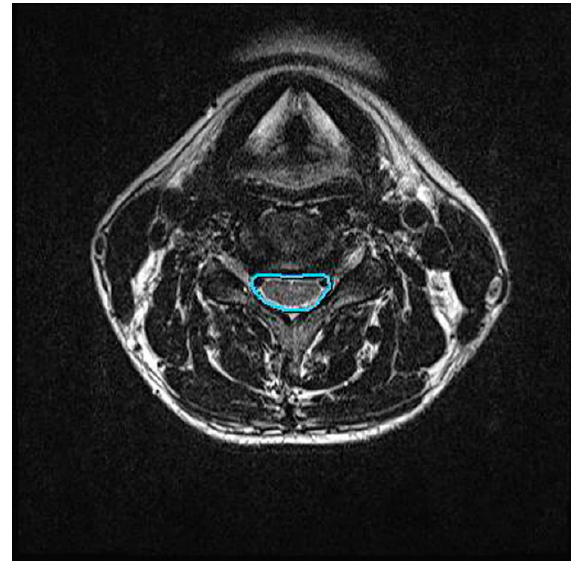
Figure 3. Central canal area in axial view of cervical spine MRI.